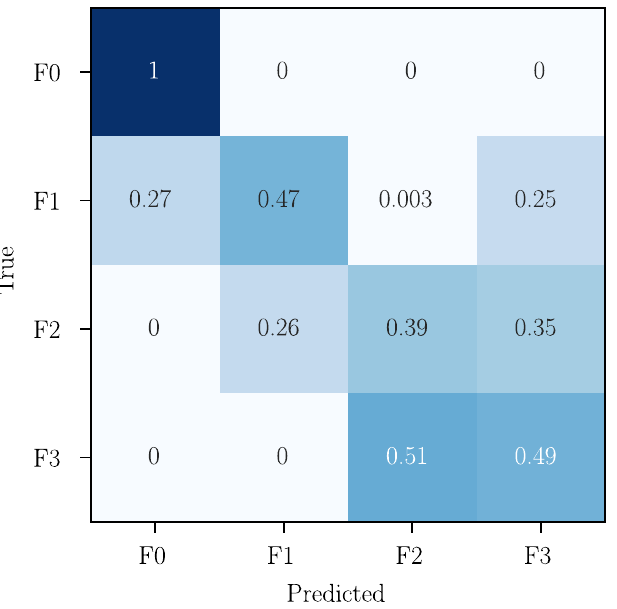
Figure 7. Confusion matrix for the source dataset FDD obtained with a model trained using only the source dataset samples (Source → Source).